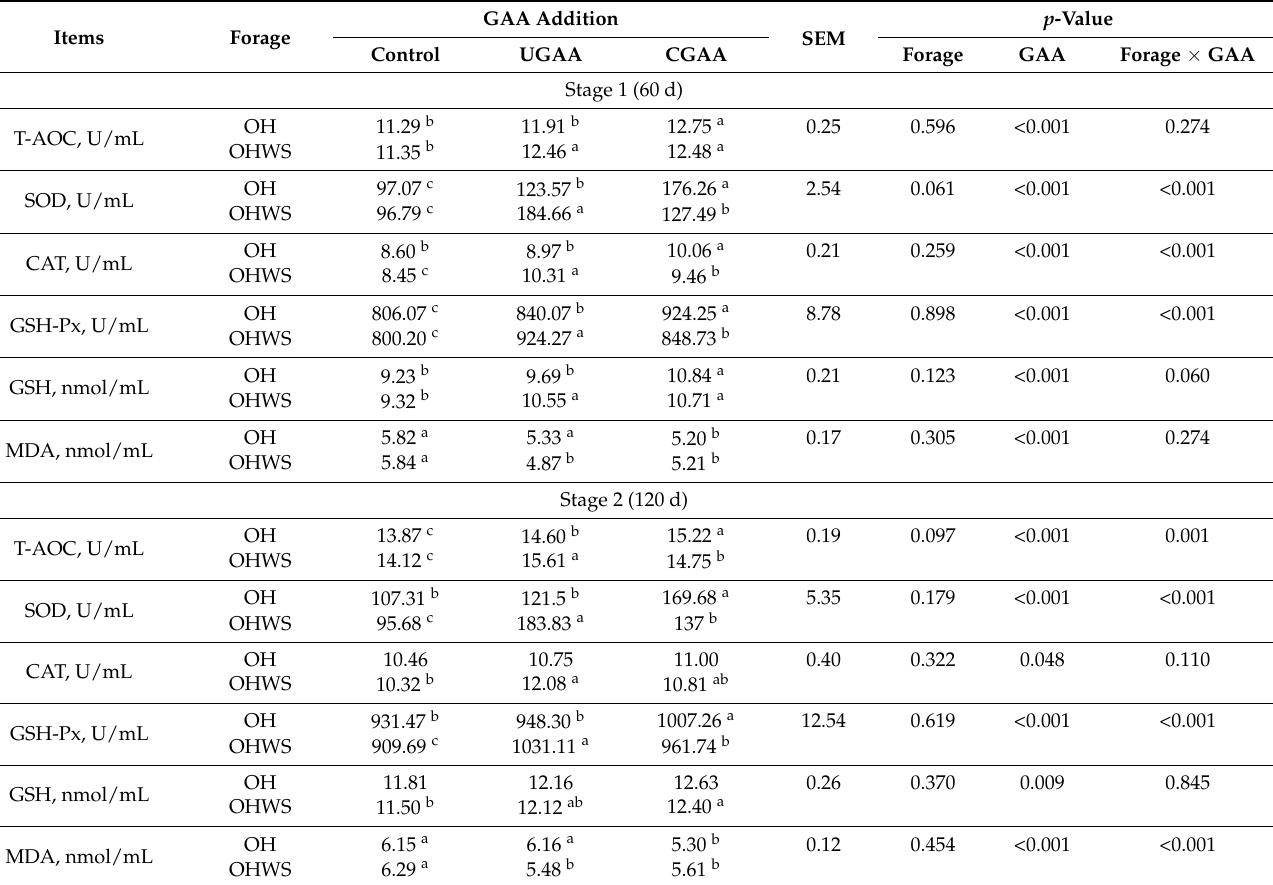
Table 5. Effects of forage type and GAA addition on ruminal antioxidant